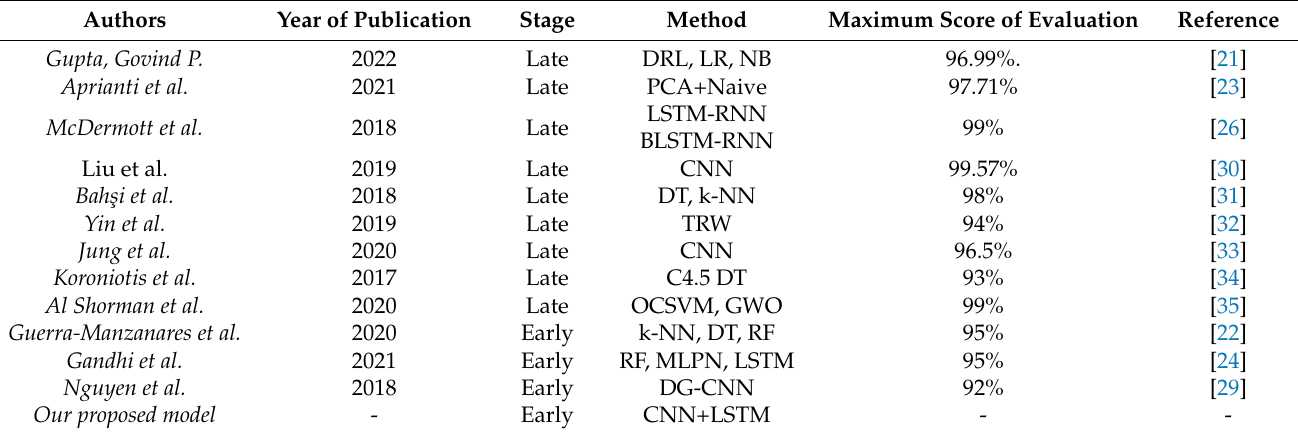
Table 2. The methods that were used in state-of-the-art studies to detect IoT botnet in early stage and late stage.